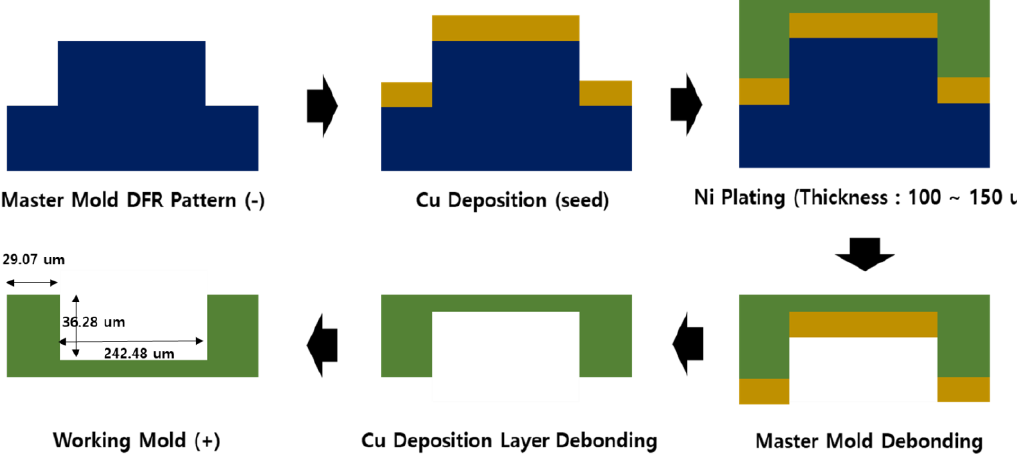
Figure 2. Manufacturing process of working pattern mold for imprinting. Blue —master pattern, Yellow —copper coating, Green — nickel plating.